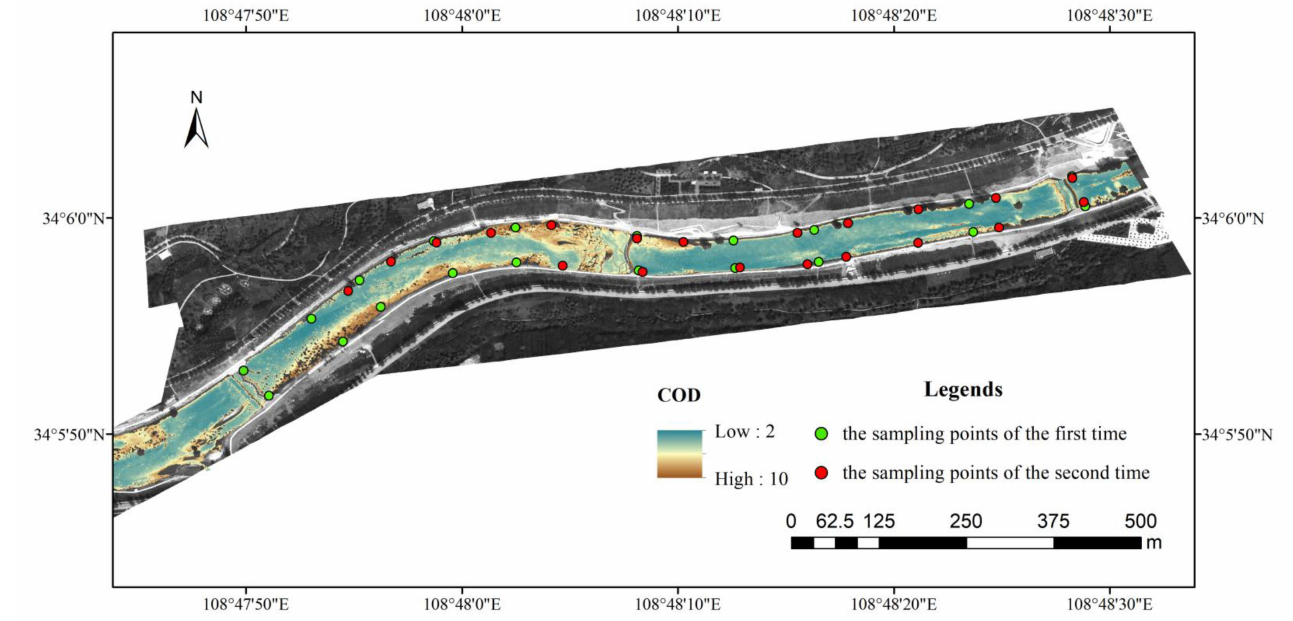
Figure 2. The sampling points of two experiments along Xiao River combining with the COD inversion map on 11 April.